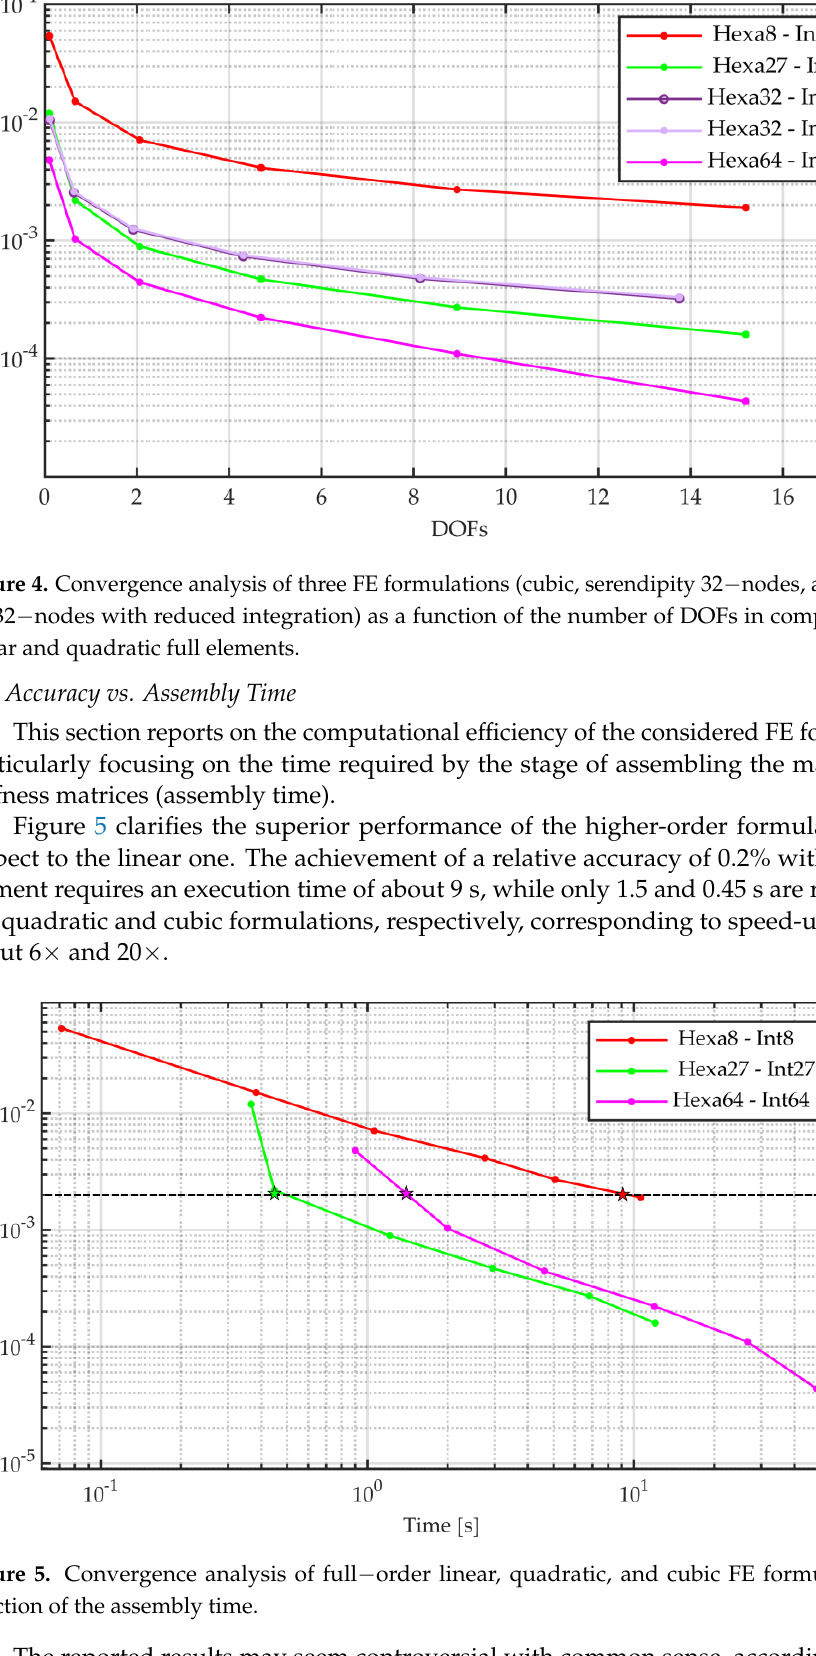
Figure 3. Convergence analysis of three FE formulations (quadratic, serendipity 20 − nodes, and ser- endipity 20 − nodes with reduced integration) as a function of the number of DOFs in comparison with linear and cubic full elements.